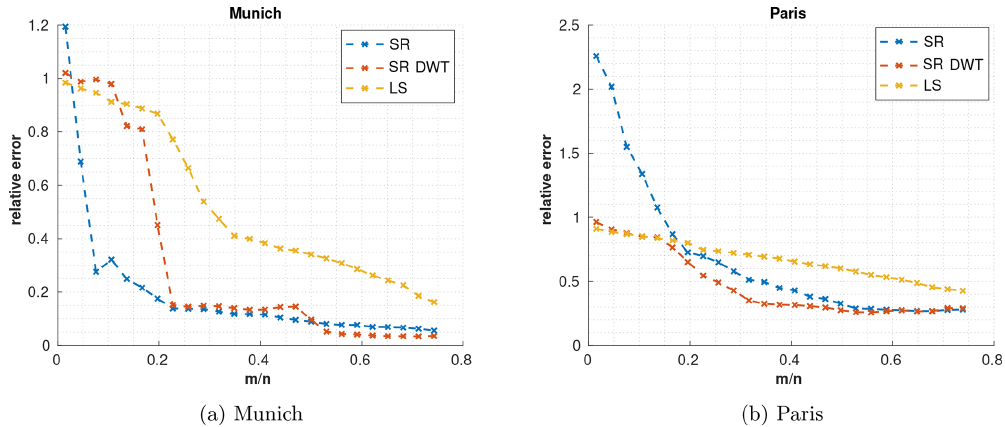
Figure 8. Relative error for SR, SR with DWT, and LS at different degrees of undersampling, for (a) Munich and (b) Paris.